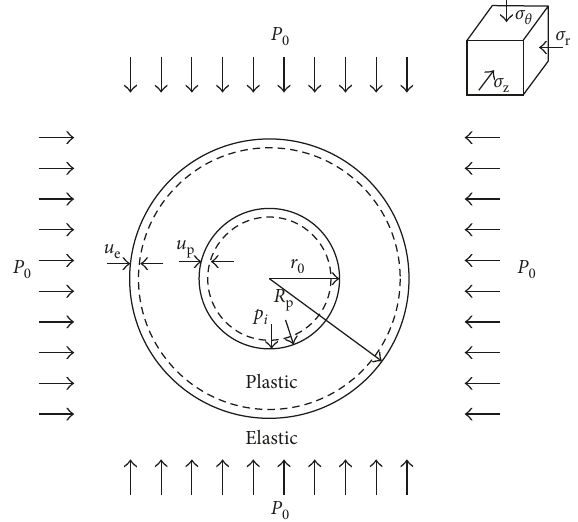
Figure 2: Calculation model of tunnel surrounding